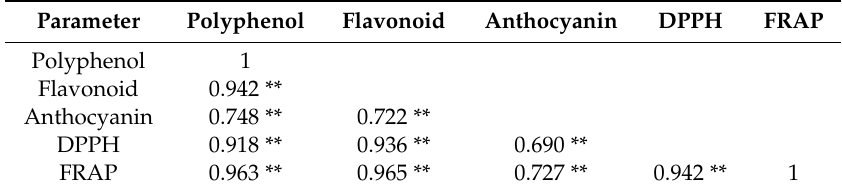
Table 4. The correlation analysis of antioxidant component and capacity affected by the interaction of photoperiod and NSC.